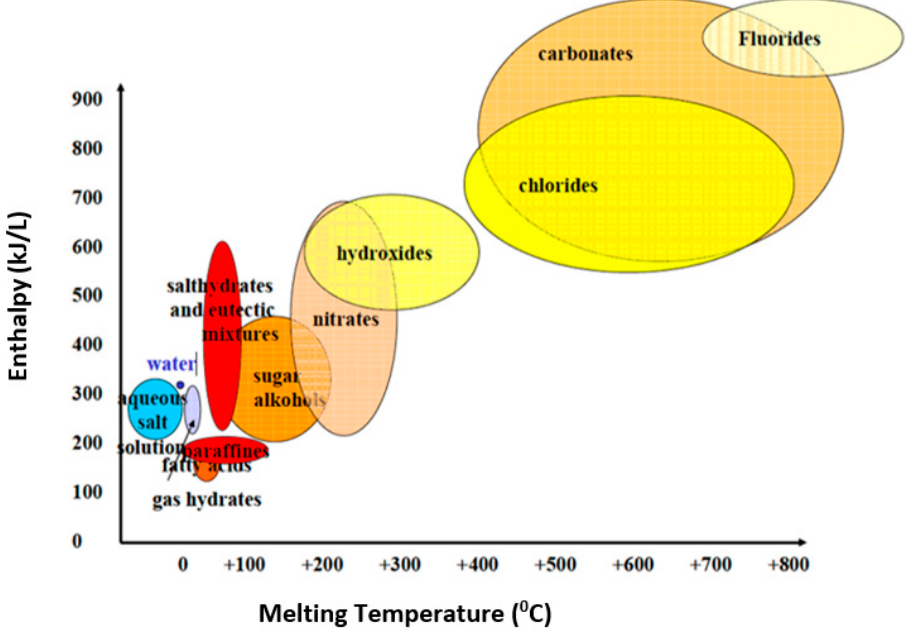
Figure 1. PCMs according to their melting temperatures and enthalpy. Adapted from [10].